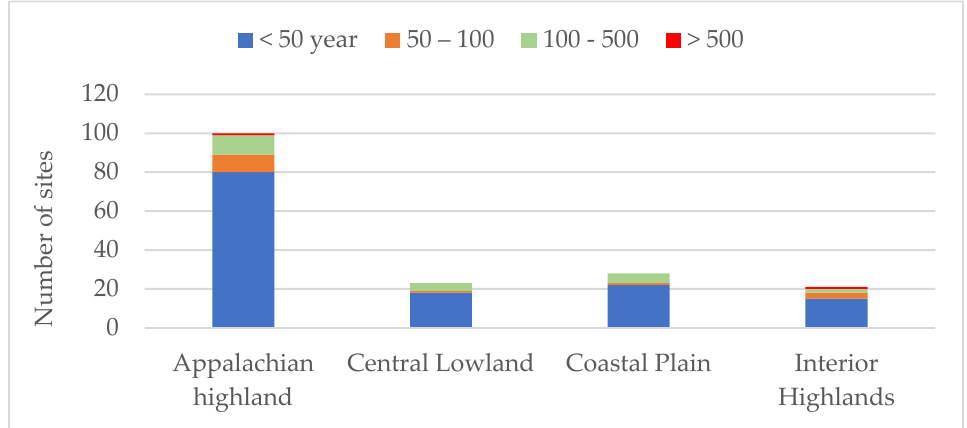
Figure 15. Return periods for heavy tail flows of the bridge collapse sites across different regions .